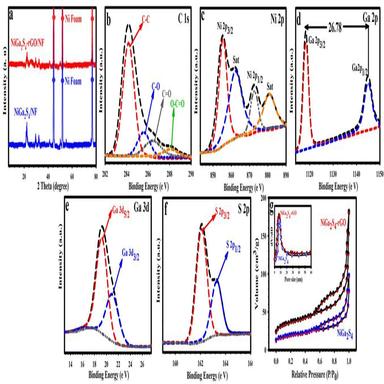
(a) XRD pattern of the NiGa2S4/NF and NiGa2S4-rGO/NF electrodes. (b) High-resolution XPS spectrum of C 1s of the NiGa2S4-rGO/NF. (c) High-resolution XPS spectrum of Ni 2p of the NiGa2S4-rGO/NF. (d) High-resolution XPS spectrum of Ga 2p of the NiGa2S4-rGO/NF. (e) High-resolution XPS spectrum of Ga 3d of the NiGa2S4-rGO/NF. (f) Highresolution XPS spectrum of S 2p of the NiGa2S4-rGO/NF. (g) N2 adsorption/desorption isotherm of the NiGa2S4/NF and NiGa2S4-rGO/NF and their corresponding BJH pore size distribution